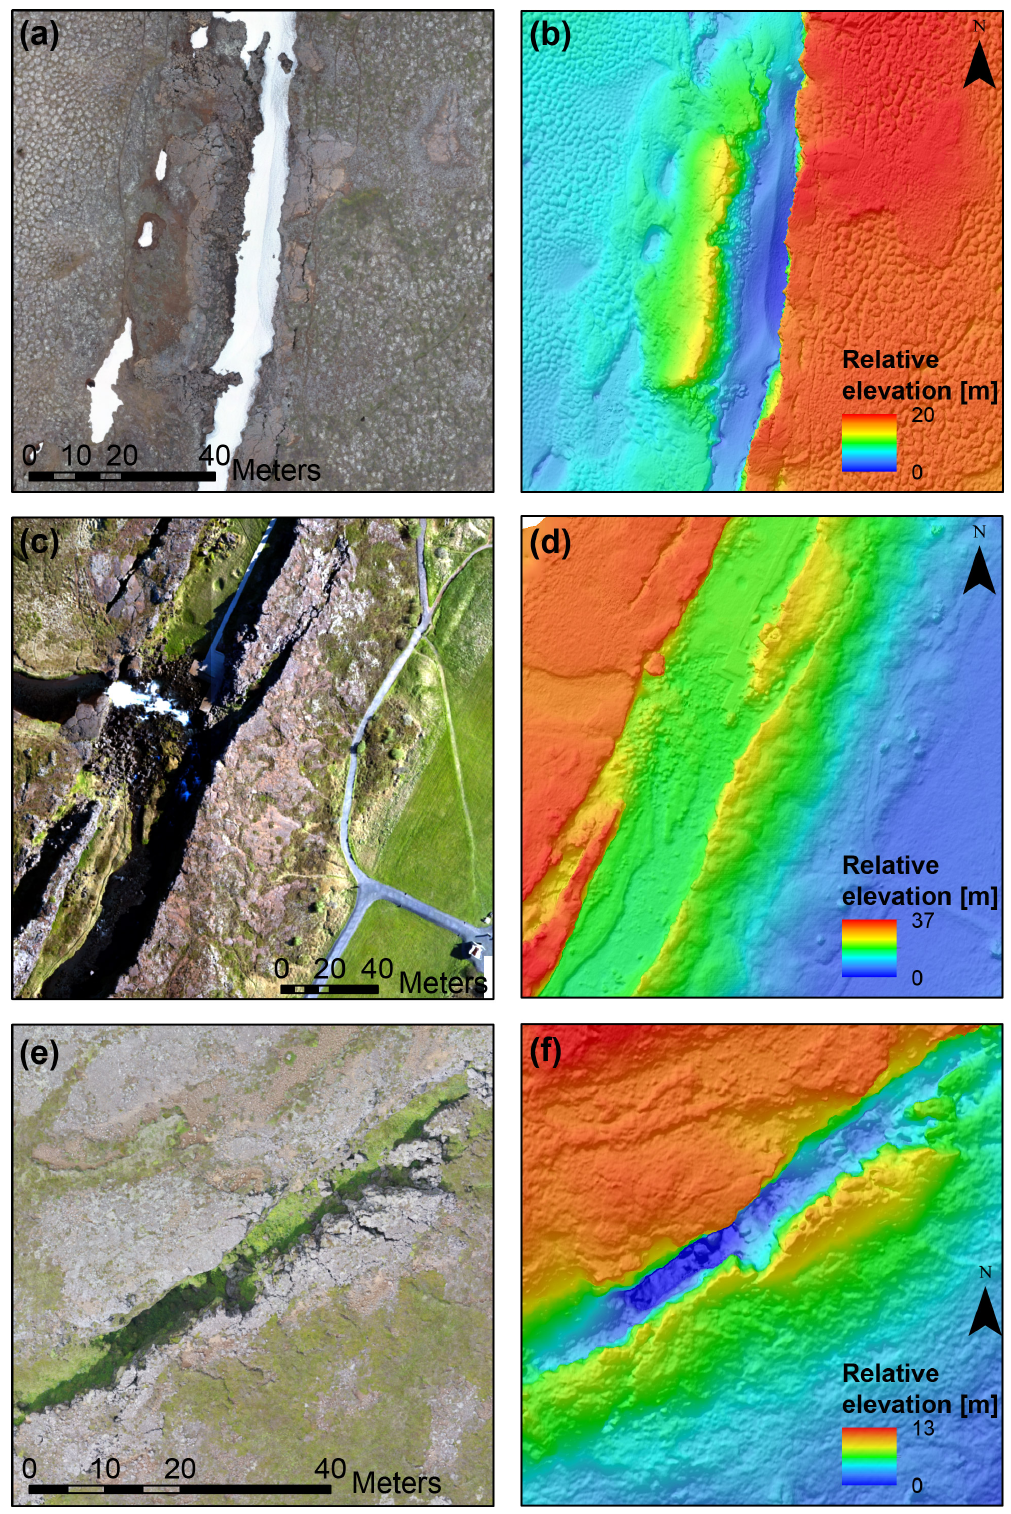
Figure 16. Samples showing the resolution of our DEMs and orthomosaics on tilted blocks: (a, c, e) orthorectified mosaics and (b, d, f) DEMs. (a, b) Krafla; the opening is partly filled by snow. The surface dip of the TB is visible in the DEM; 65 ◦ 51 (cid:48) 19 (cid:48)(cid:48) N, 16 ◦ 43 (cid:48) 23W. (c, d) Partly segmented TB in Thingvellir, including the Öxarárfoss waterfall; 64 ◦ 15 (cid:48) 56 (cid:48)(cid:48) N, 21 ◦ 7 (cid:48) 4 (cid:48)(cid:48) W. (e, f) TB dipping towards the south in Vogar; 63 ◦ 58 (cid:48) 19 (cid:48)(cid:48) N, 22 ◦ 20 (cid:48) 29 (cid:48)(cid:48) W. Projection: WGS1984 UTM 27N and